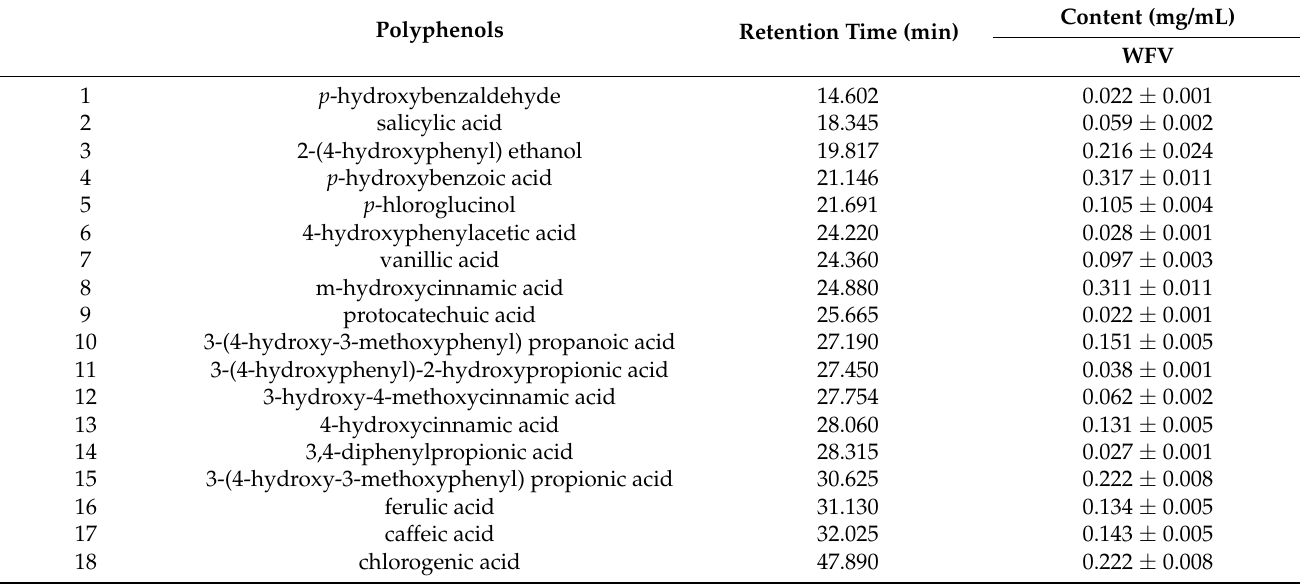
Table 3. GC-MS analysis of polyphenols in